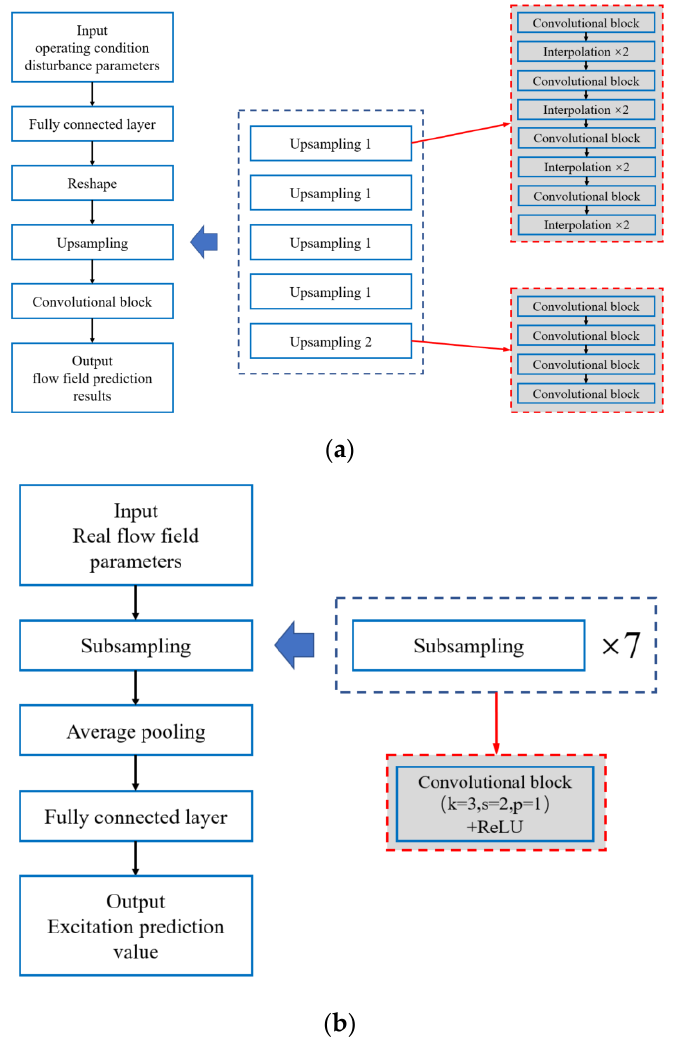
Figure 2. Network structure. ( a ) Field reconstruction network; ( b ) performance prediction network.